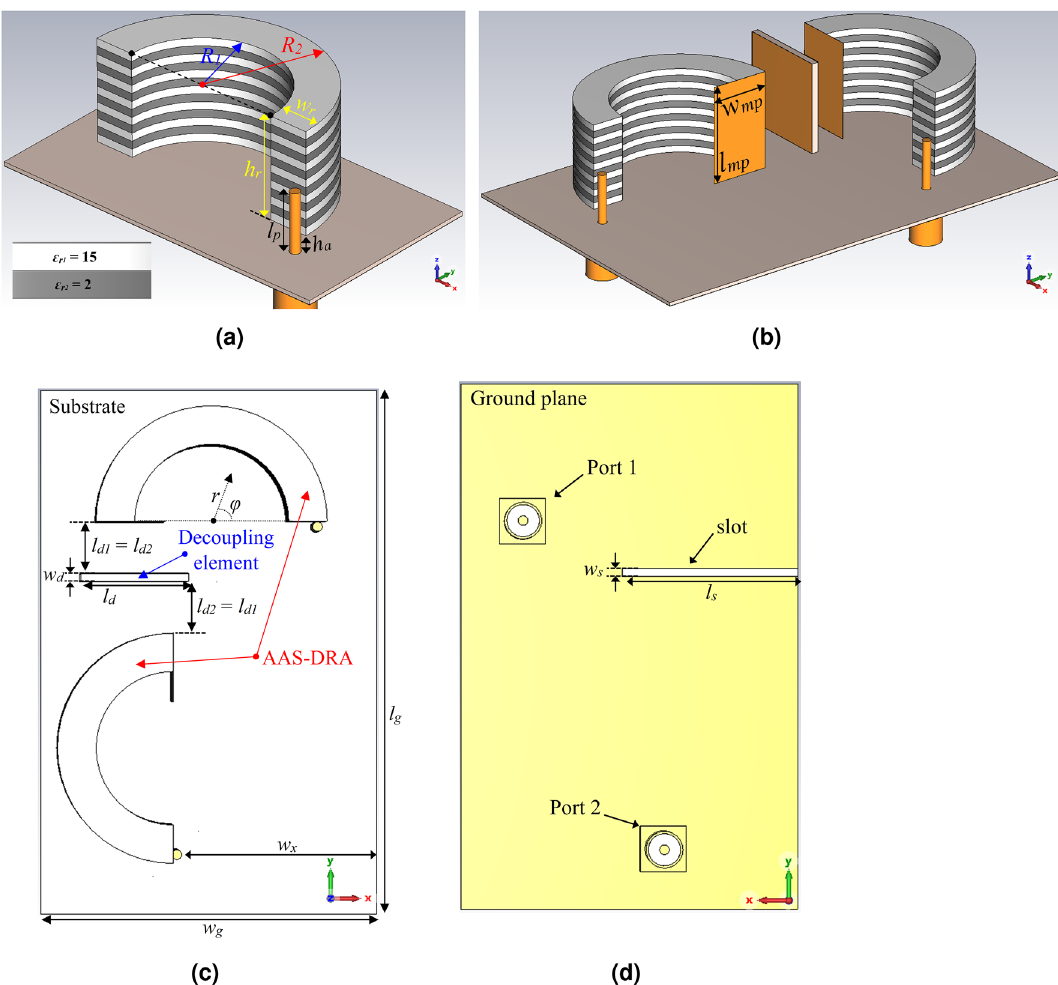
Figure 1. Geometry of the proposed antenna: ( a ) single, ( b ) IBFD (3D view), ( c ) IBFD (top view), and ( d ) IBFD (back view) with l g = 69 , w g = 44 , l mp = 15 , l p = 7.5 , l s = 23 , l d = 14 , l d 1 = l d 2 = 6.8 , w mp = 9 , w s = 1 , w d = 1 , w x = 26.4 , w r = 5 , h 1 = h 2 = 1 , h r = 13 , h d = 14 , h a = 2 , R 1 = 10 , R 2 = 15 , ε r 1 = 15 , ε r 2 = 2 ,